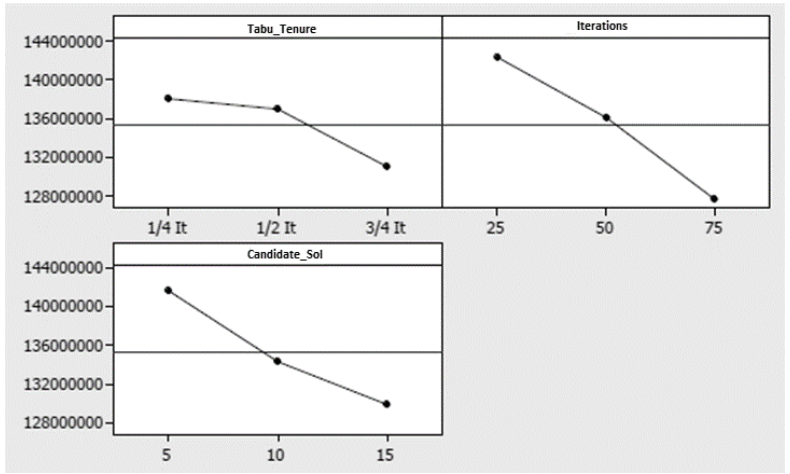
Figure 3. Main effects plot for total planning cost in large instances. Source: Minitab R (cid:13)